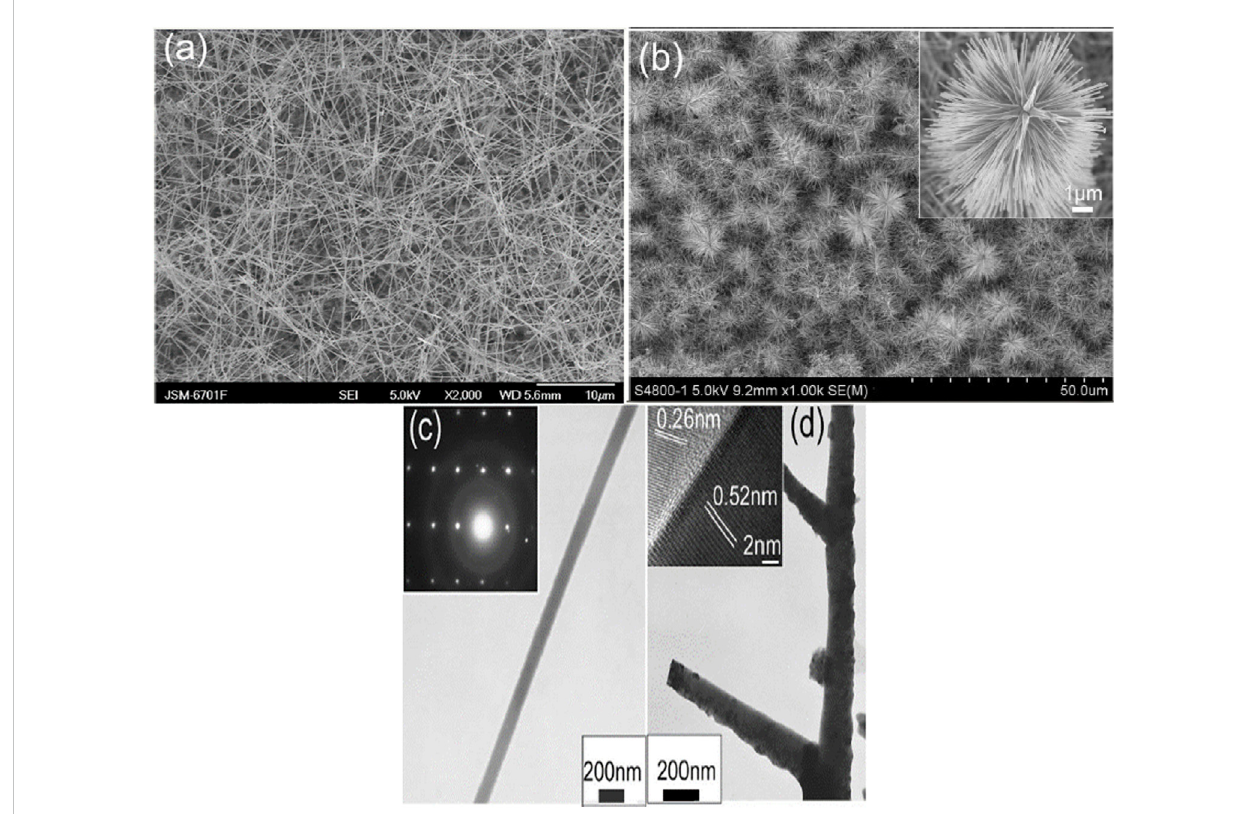
FIGURE 21 SEM images of ZnO (A) nanowires and (B) nanotrees as well as TEM images of ZnO (C) nanowires and (D) branches of the nanotrees (Zhuo et al., 2008).